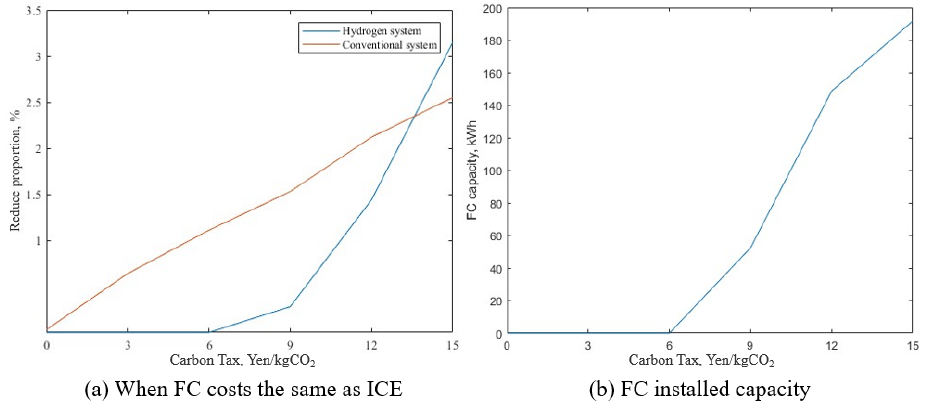
Figure 6. Proportion of the total cost reduction under different carbon taxes (FC costs the same as ICE) ( a ) and FC installed capacity under different carbon taxes ( b ).